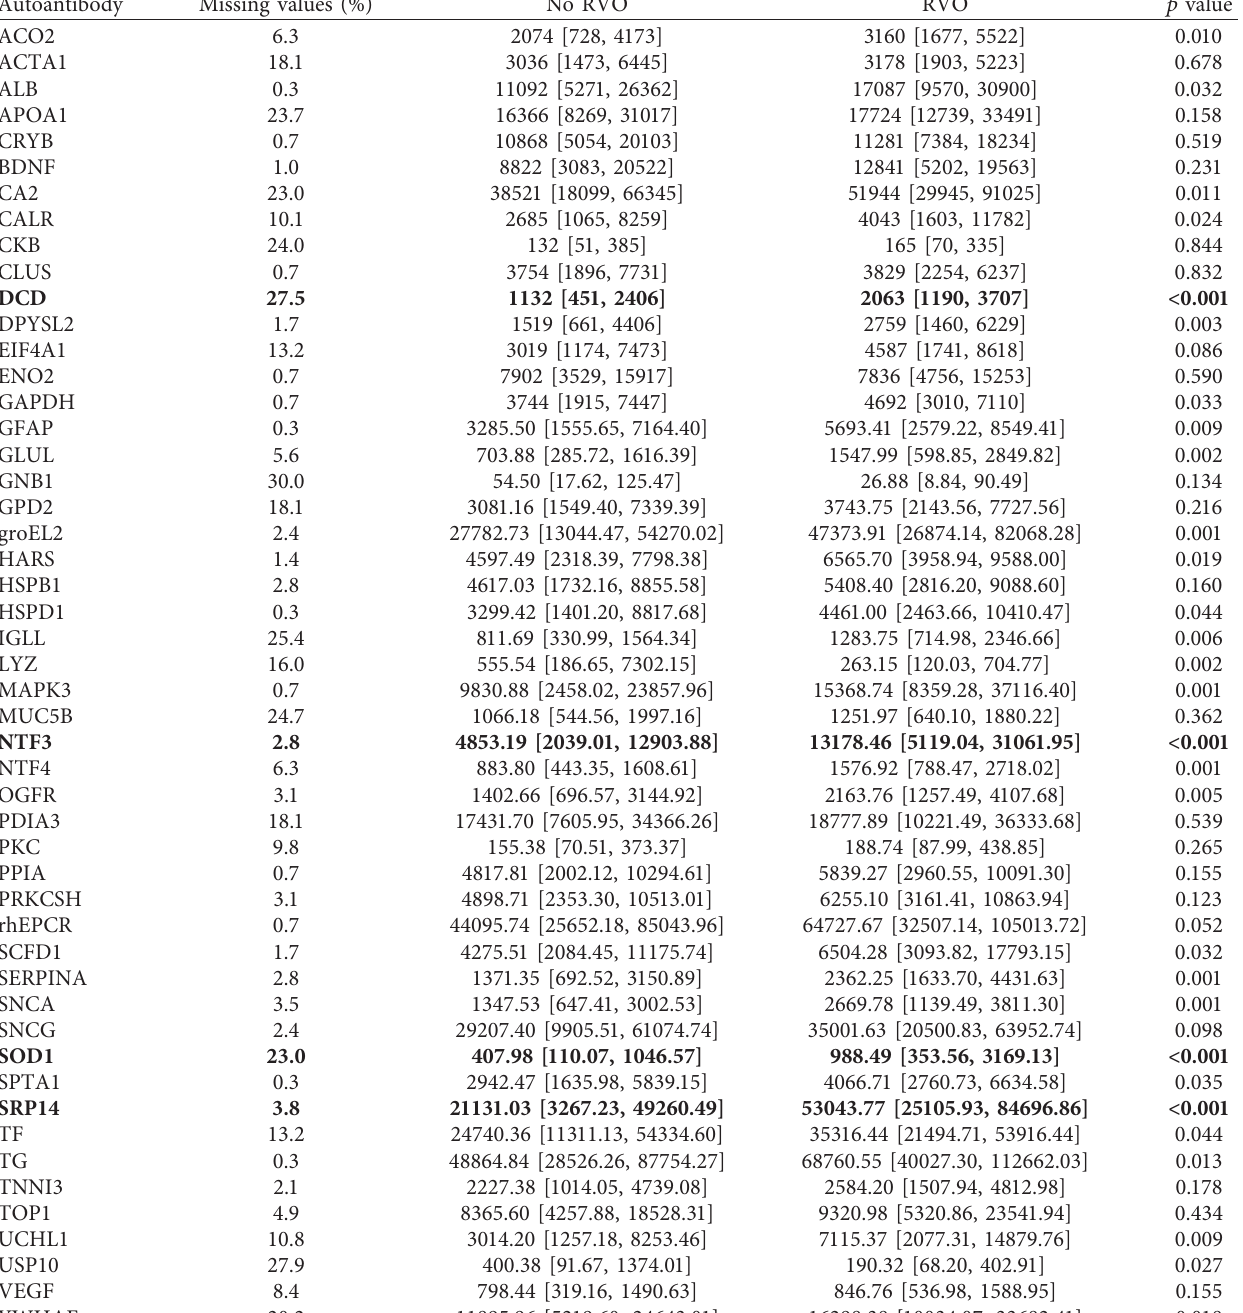
Table 2: Measurement of autoantibody abundancies in the study sample of the German population-based Gutenberg Health Study